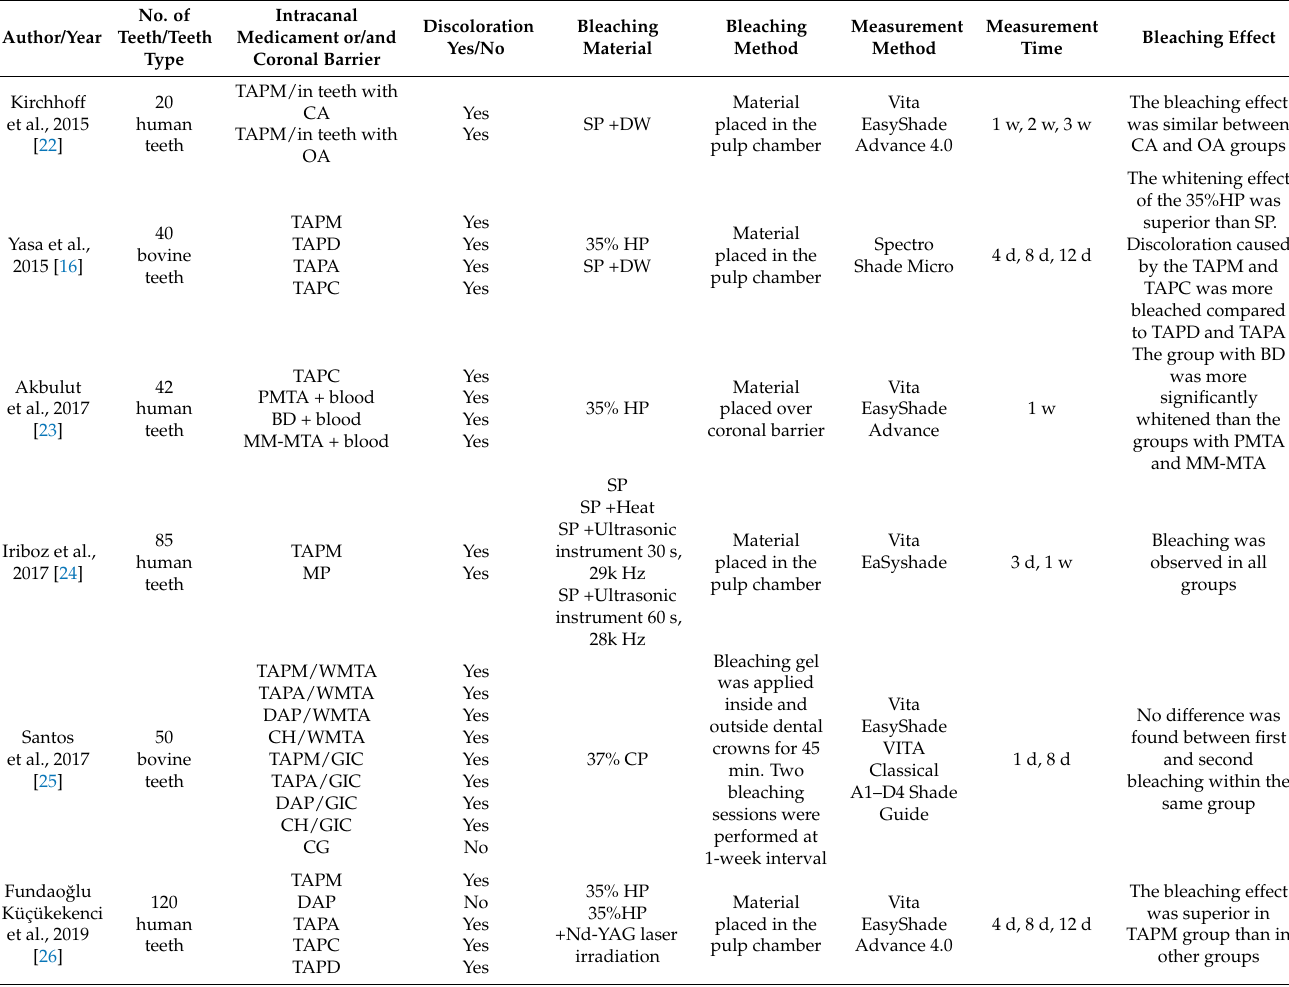
Table 4. Data pertaining to analyzed in vitro